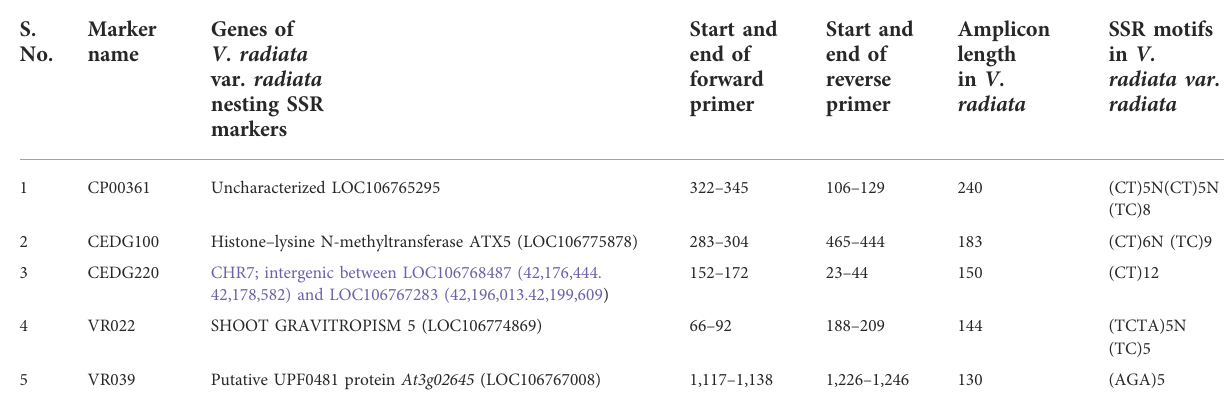
TABLE 3 Trait-linked SSRs fl anking candidate genes in V. radiata . S.